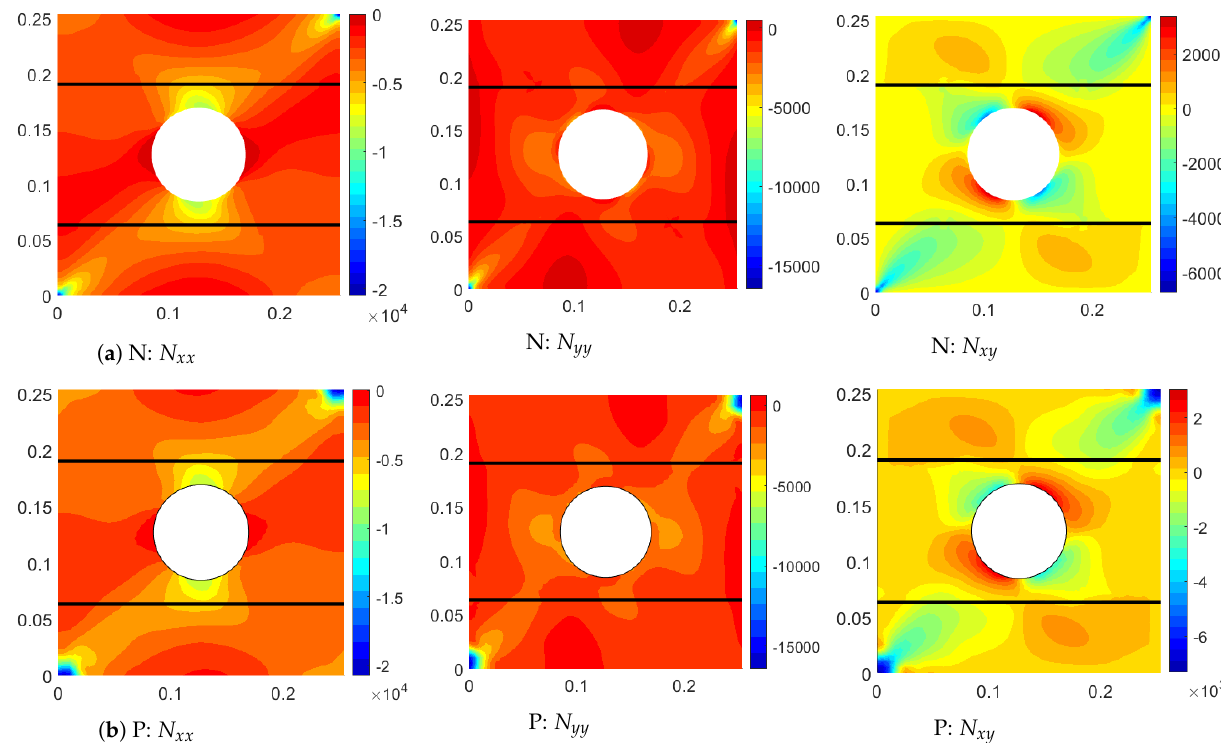
Figure 9. Comparison of stress resultants (unit: N/m) of the stiffened VAT laminates with a central hole under uniform axial displacements. ( a ) N: NASTRAN results; ( b ) P: Present